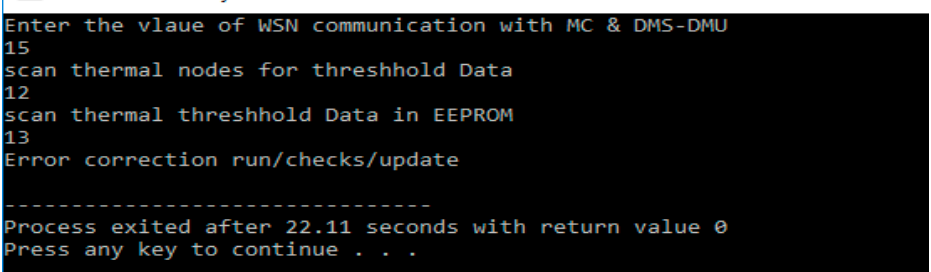
Figure 7. Normal operating temperature (15–30 °C).